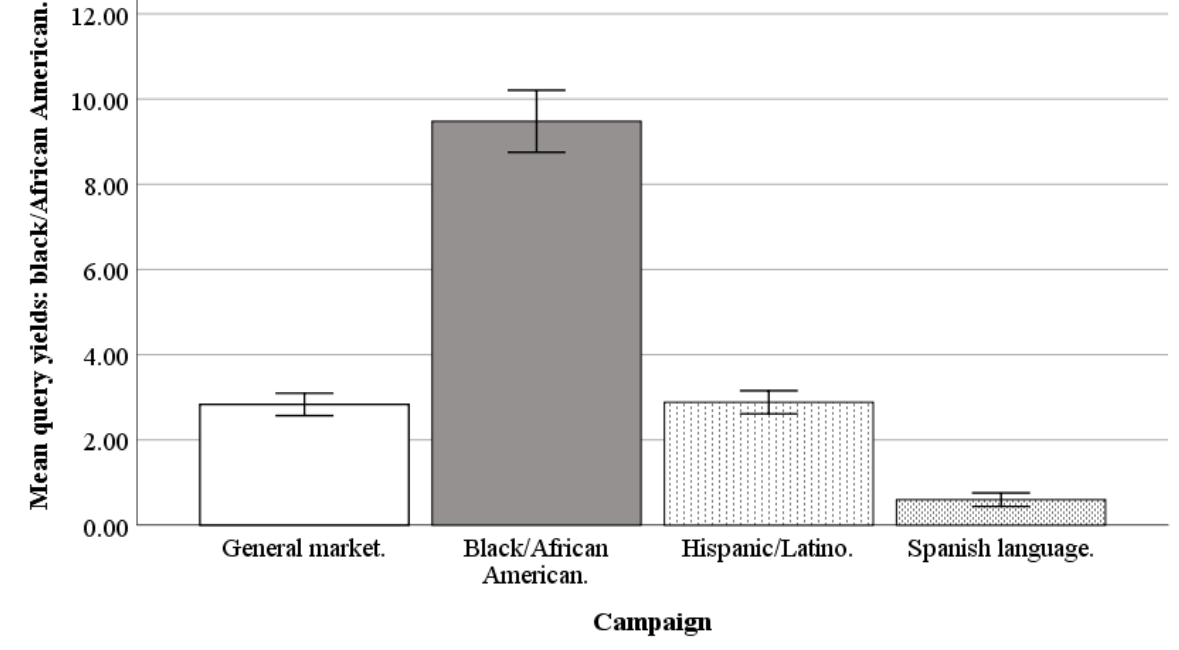
Figure 2. Mean query yields of blacks/African Americans for Facebook advertising